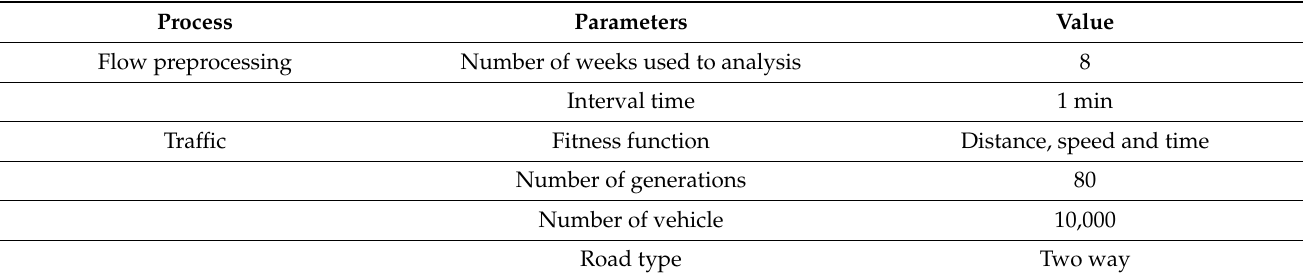
Table 2. Simulation